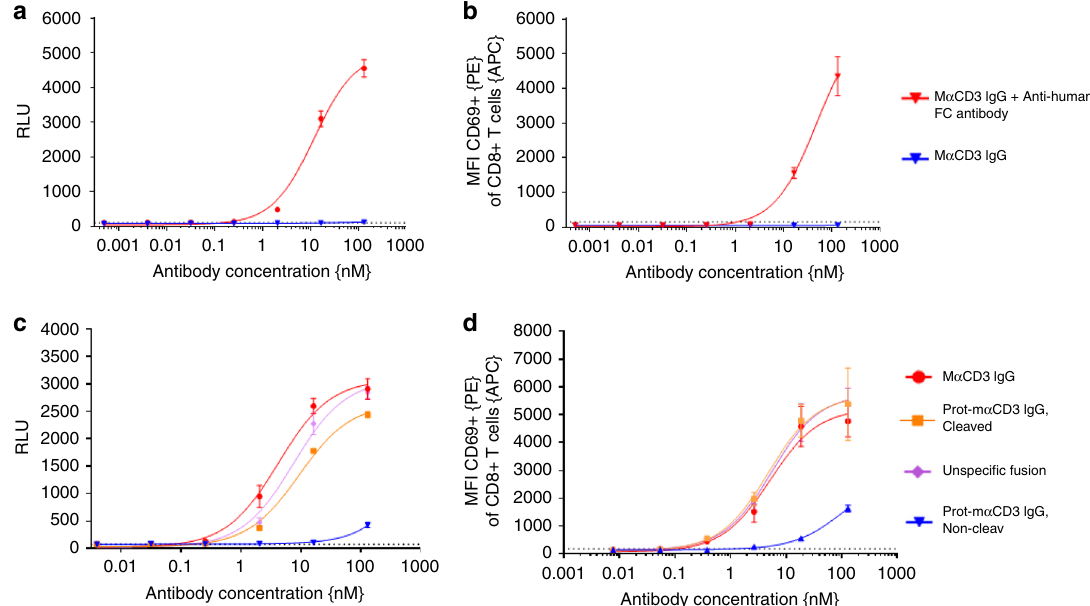
Fig. 4 T-cell activation is reversibly impaired by blocking anti-CD3 binder. T-cell/Jurkat NFAT activation is dependent on crosslinking of m α -CD3. a Monovalent anti-CD3 IgG is able to activate luciferase in a Jurkat NFAT luciferase reporter cell line after crosslinking by plate-coated anti-human Fc (red curve) whereas in the absence of crosslinking no luciferase activity can be detected (blue curve). The dotted line indicates the luminescence for Jurkat NFAT-cells without m α -CD3 IgG on plate-coated anti-human Fc. Each value represents the mean of triplicates, standard deviation is indicated by error bars (representative experiment of n = 3). b Monovalent α -CD3 IgG is able to activate CD8-positive T cells, measured by quanti fi cation of the early activation marker CD69, after crosslinking by plate-coated anti-human Fc (red curve) whereas in the absence of crosslinking no CD8-positive T-cell activation can be detected (blue curve). The median fl uorescence intensity (MFI) for CD69 of CD8 T cells is shown. Each value represents the mean of triplicates, standard deviation is indicated by error bars (representative experiment of n = 3). c , d m α CD3 IgGs were bound to plate-coated anti-human Fc antibody before Jurkat NFAT reporter cells or PBMCs were added. Jurkat NFAT activation is measured in relative luminescence units (RLU) and T-cell activation was assessed by quanti fi cation of CD69 by FACS analysis. Cleavage of the Prot-m α CD3 IgG containing a matriptase cleavable linker was performed by incubation of Prot-m α CD3 IgG with puri fi ed recombinant human matriptase for 24 h at 37 °C. c Jurkat NFAT activation mediated by Prot-m α CD3 IgG. Cleaved Prot-m α CD3 IgG, blocked Prot-m α CD3 IgG, m α CD3 IgG and m α CD3 IgG with an N-terminal fusion of a nonspeci fi c fusion (anti-CEA Fab) are shown. The dotted line indicates the luminescence for Jurkat NFAT-cells without any CD3 IgG. Each value represents the mean value of triplicates, standard deviation is indicated by error bars (representative experiment of n = 3). d The median fl uorescence intensity (MFI) for CD69 of CD8 T cells is shown. Each value represents the mean value of triplicates, standard deviation is indicated by error bars (representative experiment for three different human PBMC